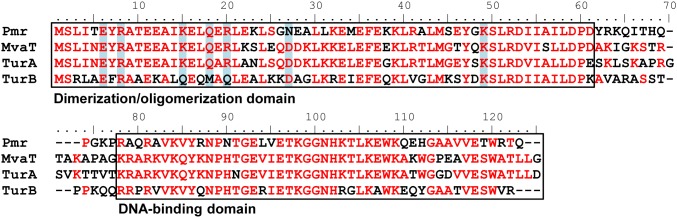
Alignments of amino acid sequences of Pmr, TurA, TurB, and MvaT of P. aeruginosa PAO1.Alignments were performed using the CLUSTAL W software, version 2.1. The amino acid residues identical in two to four members are shown in red. Dimerization/oligomerization and DNA-binding domains of Pmr and the corresponding regions in the other three proteins are indicated in the panel. The seven residues important for homo-oligomerization of Pmr, and the corresponding residues in the other three proteins, are highlighted in light blue.